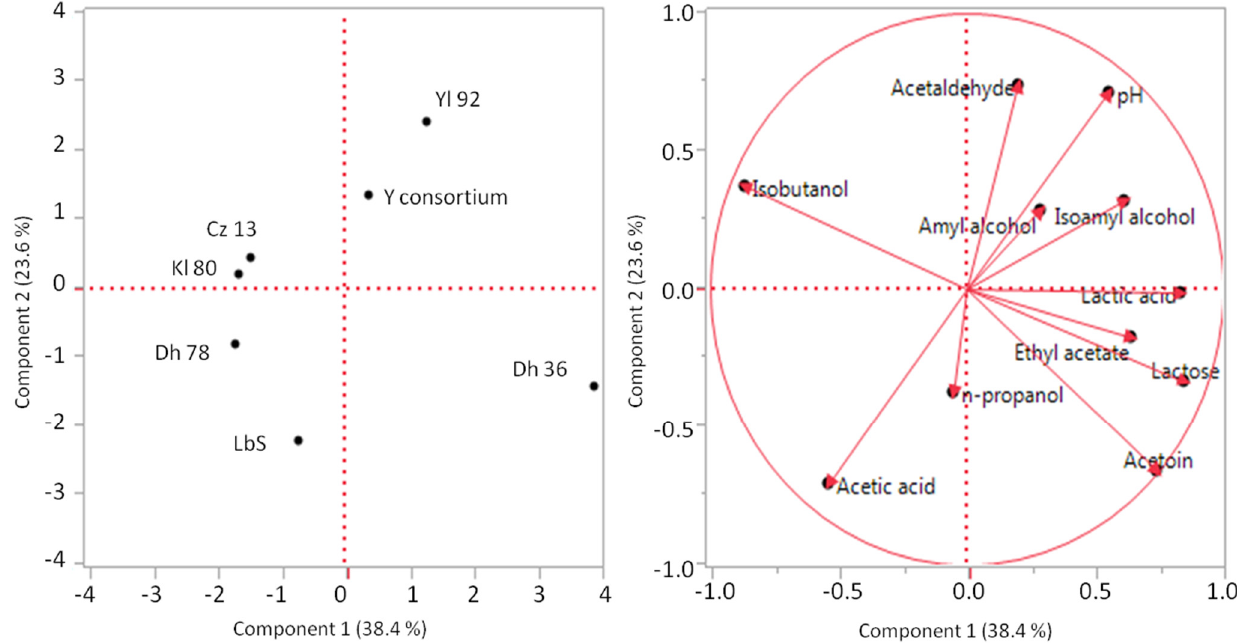
Figure 3. Principal component analysis based on the main analytical characters and by-products of fermentation from all kefir samples. Samples are reported as Dh 36 and Dh 78 for D. hansenii strains, Cz 13 for C. zeylanoides , Kl 80 for K. lactis , Yl 92 for Y. lipolytica , Y consortium for the yeast consortium, and LbS for the control.